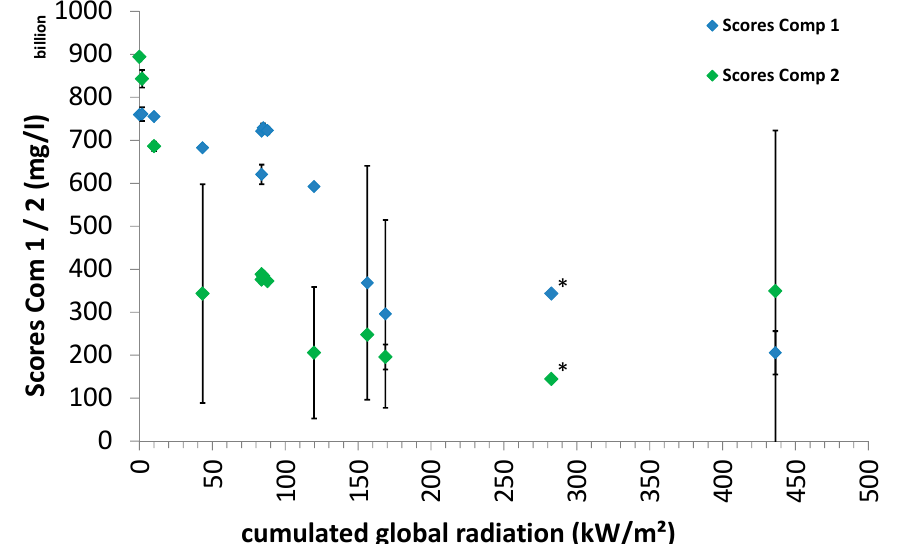
Figure 4. Scores of the first and second component (filter level 0.2 µm) of the calculated parallel factor analysis (PARAFAC) model depended on the cumulated global radiation. The blue points are the scores of the first and the green of the second component. Dots marked with * are median of the water samples and had no standard deviations, because there were only 2 instead of 3 replicates.